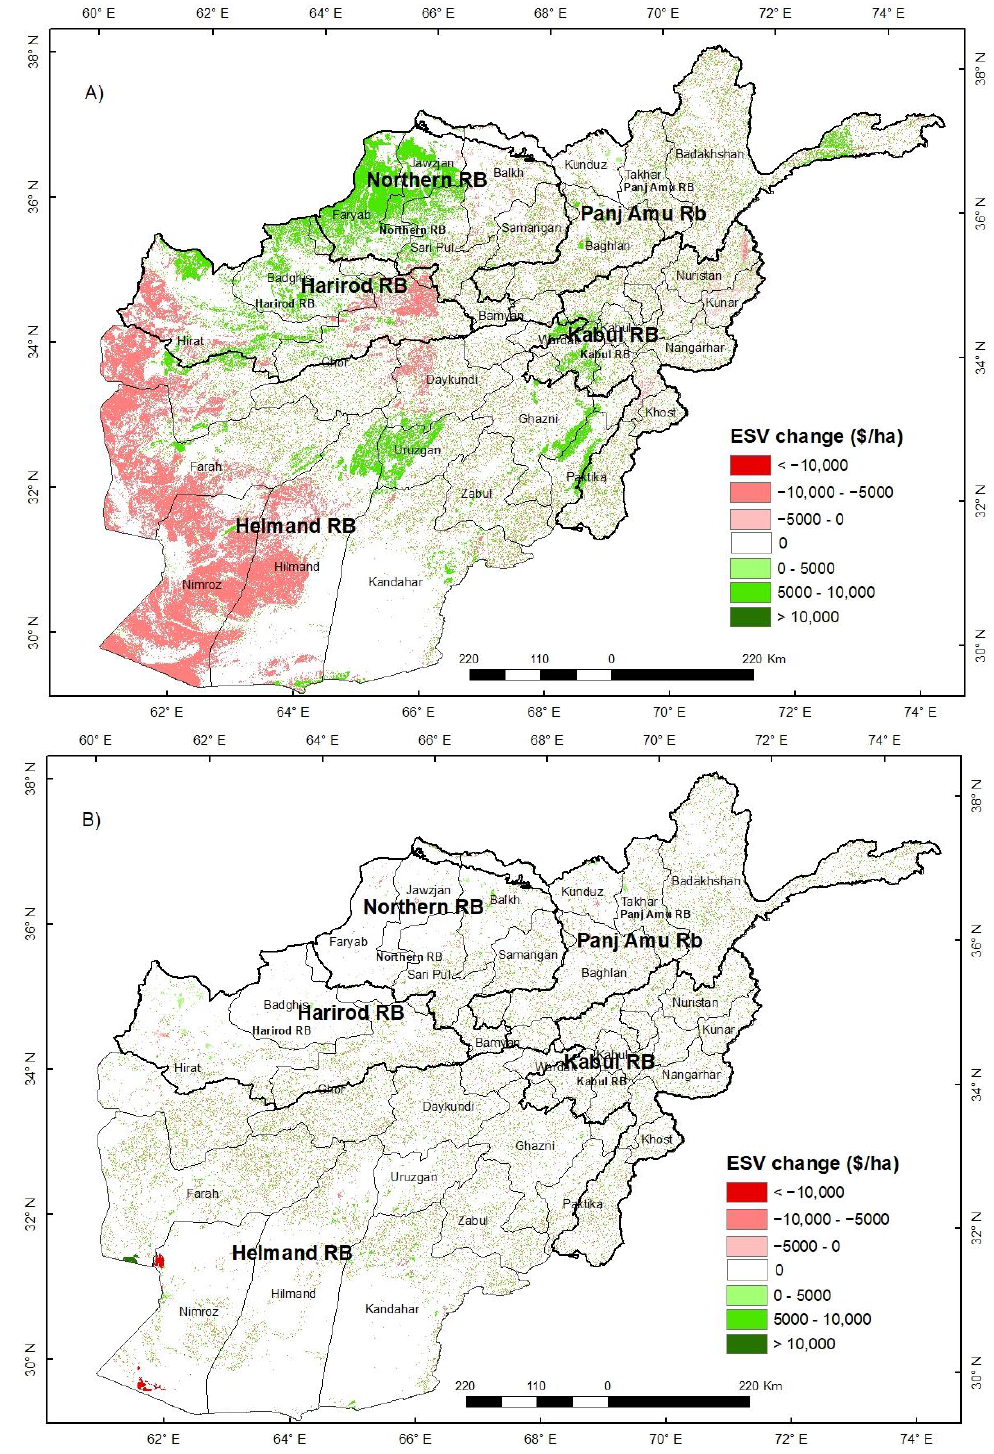
Figure 7. Spatial distribution of ESV changes during; ( A ) Period I (2000 – 2010) and ( B ) Period II (2010 – 2020).